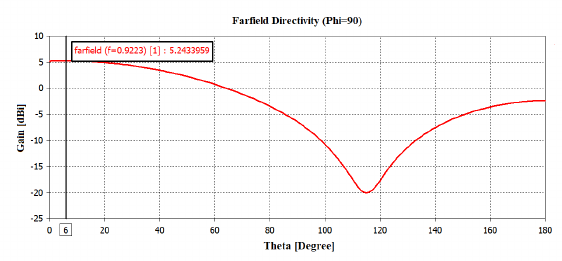
Fig. 4. Gain versus theta for φ = 90 ◦